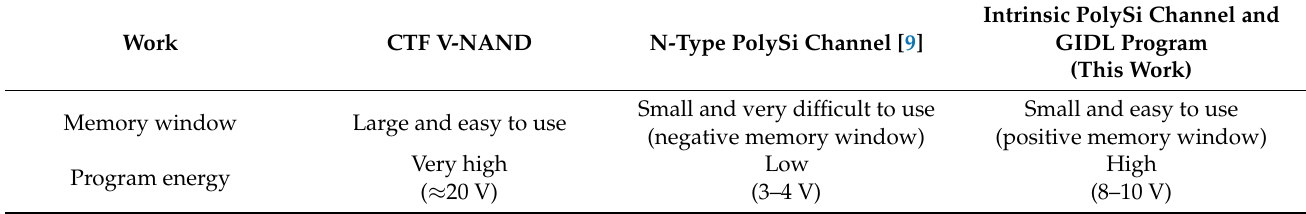
Table 3. Performance comparison of published ferroelectric V-NAND